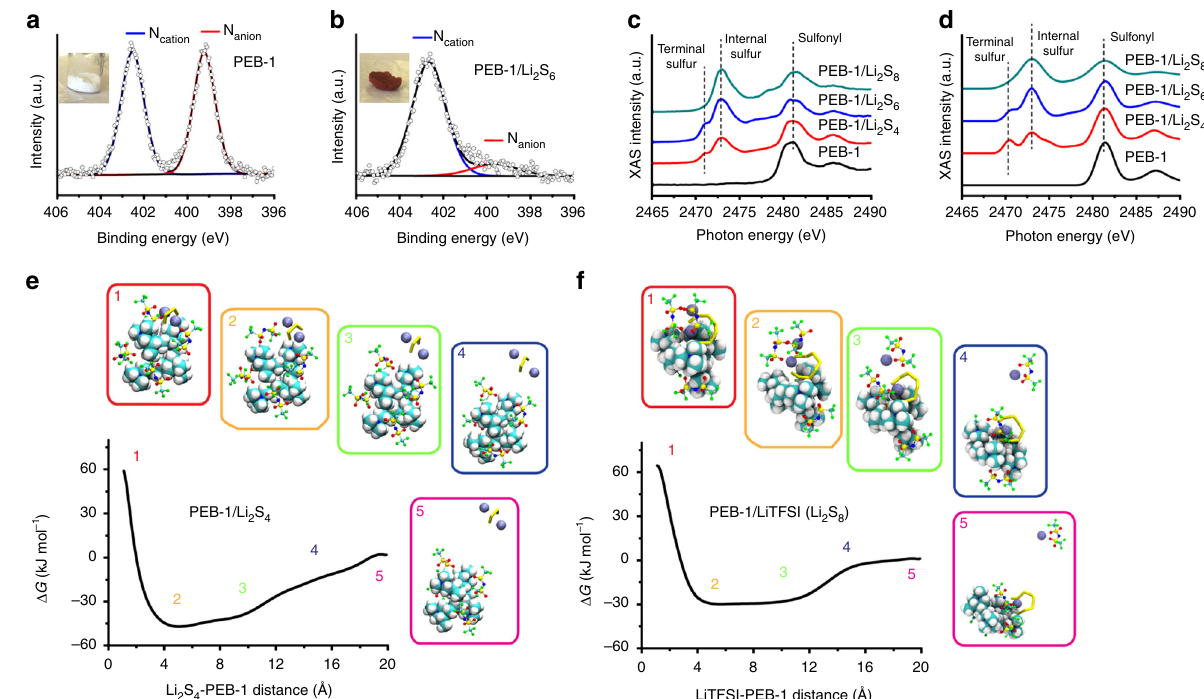
Fig. 3 Analysis of the polysul fi de – PEB-1 composite. a , b X-ray photoelectron spectroscopy (XPS) of the N 1 s signal. c Sulfur K-edge X-ray absorption (XAS) spectra. d Calculated XAS spectra. e Free energy corresponding to the interaction of PEB-1 and Li 2 S 4 when LiTFSI is present in the ion cluster. f Free energy corresponding to the interaction of PEB-1 and LiTFSI when Li 2 S 8 is present in the ion ring-closed LiS n ring-opens and undergoes a second metathesis event, leading to either inter- or intramolecular crosslinks. The longer oligomers were more effective at intermolecular cross- linking in the simulations (Fig. 1d).